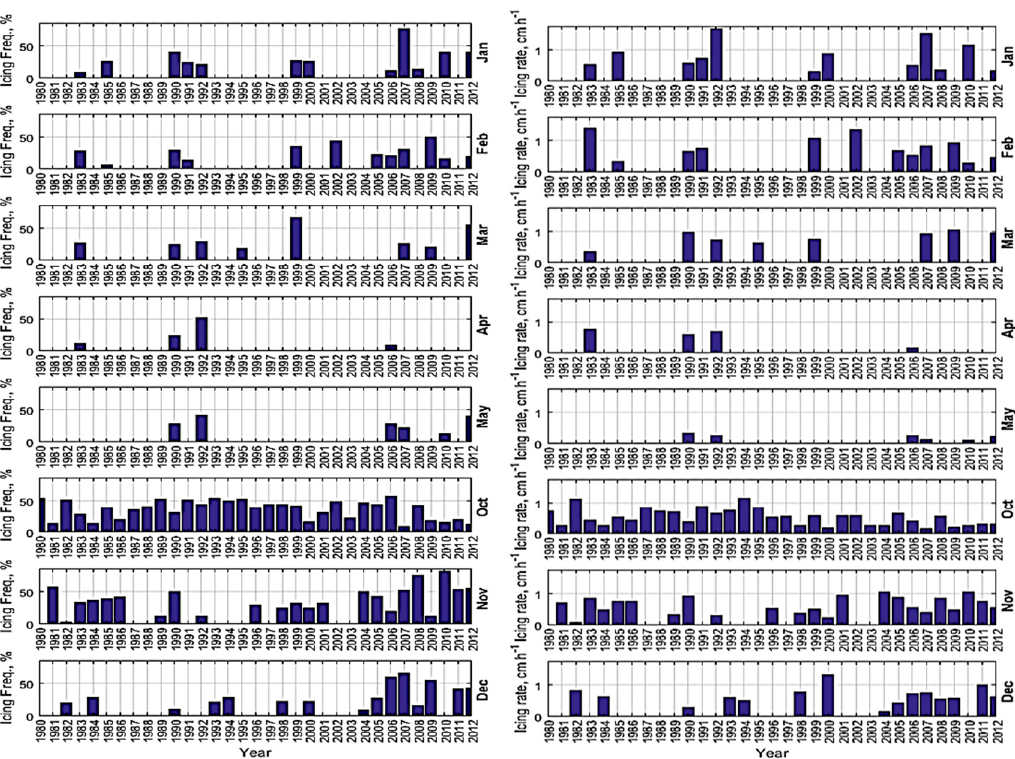
Figure 12. Yearly profile of icing rate and icing frequency from January to May and October to December for location X specified in Figure 10.